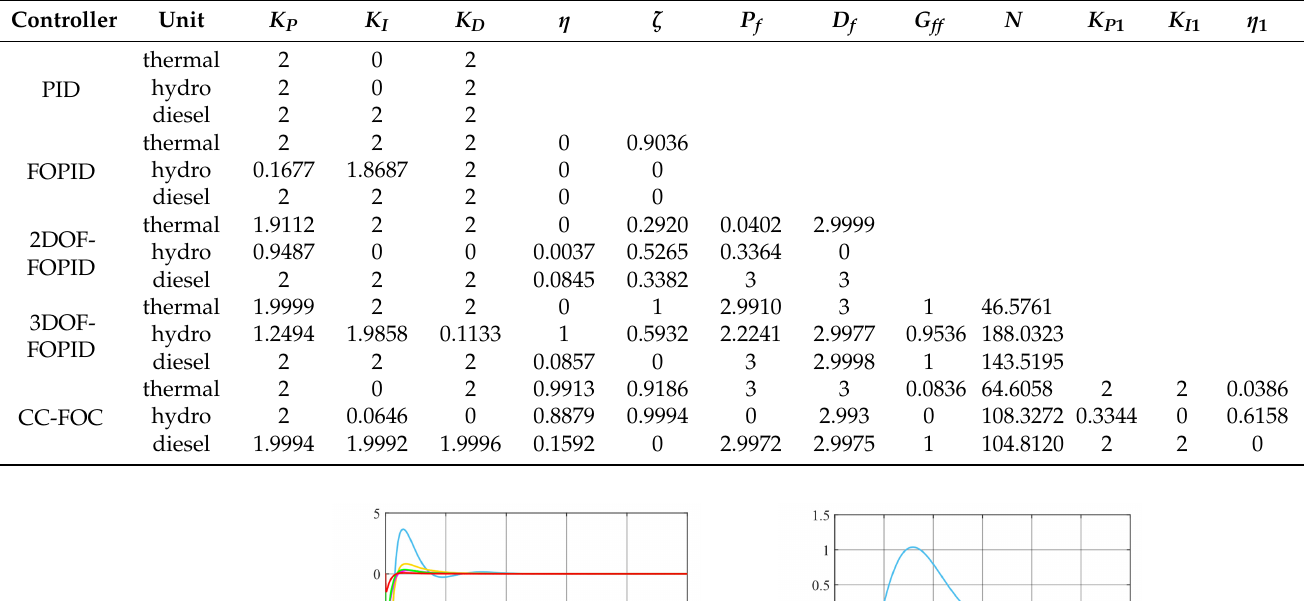
Table 2. Gains of each controller parameter.